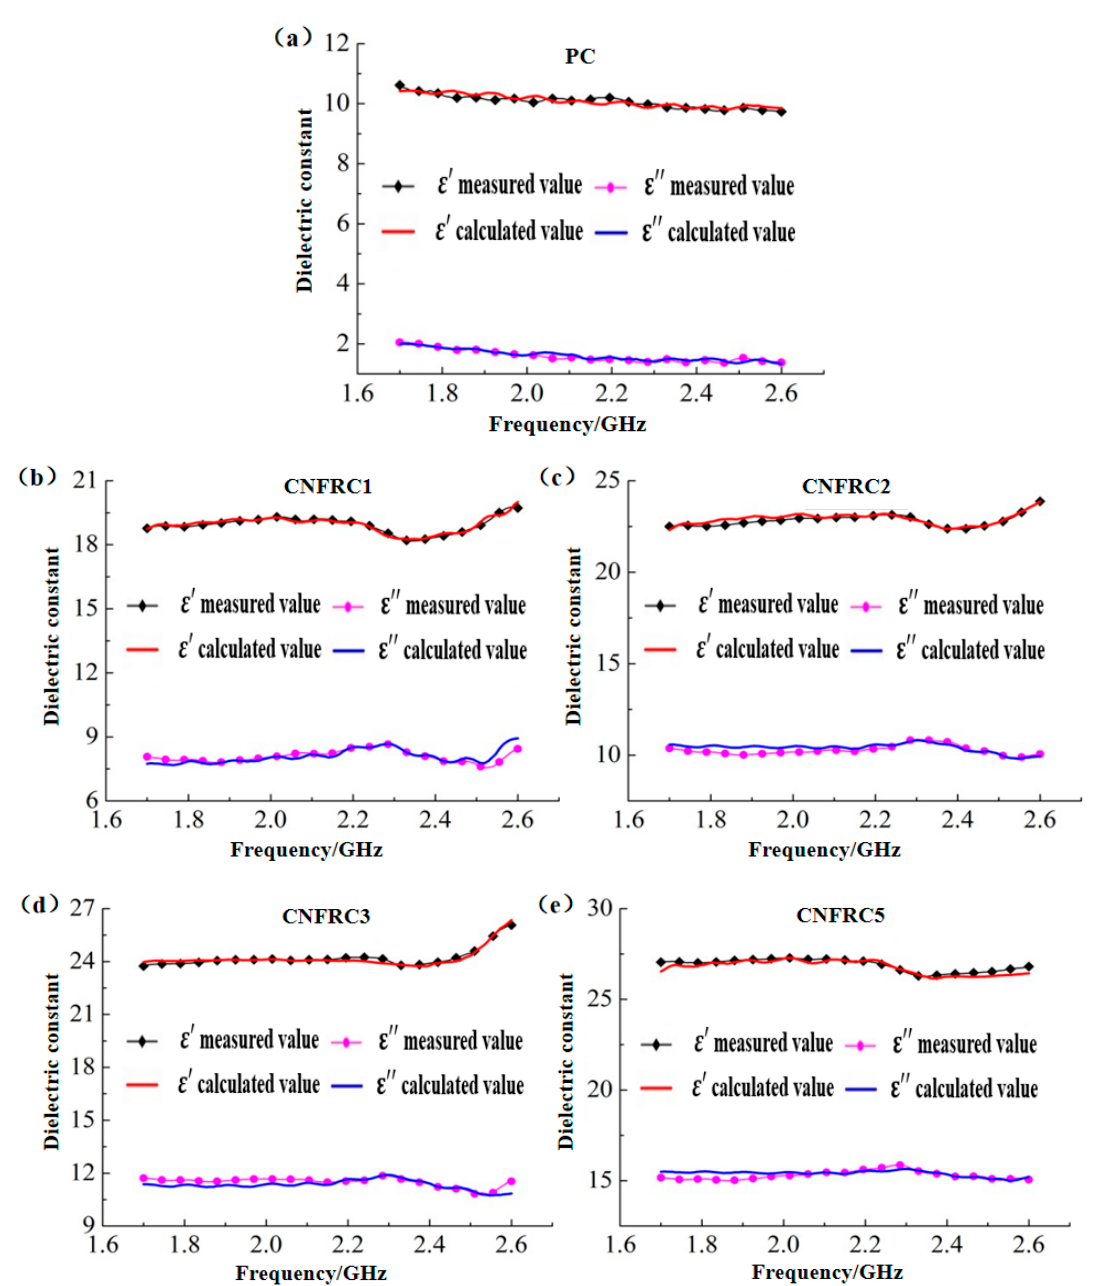
Figure 17. Verification of the measured values with the calculated values based on modified CRIM model for groups of specimens. ( a ) PC; ( b ) CNFRC1; ( c ) CNFRC2; ( d ) CNFRC3; ( e ) CNFRC5. The model curves for groups were obtained according to the modified Looyenga model